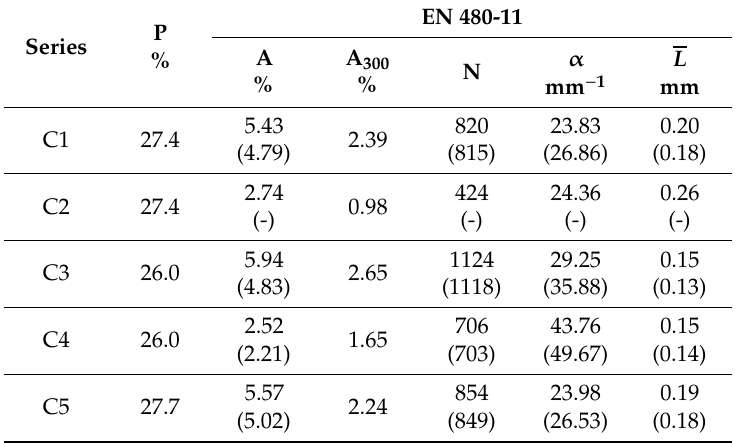
Table 2. Results of the air void parameter assessment as per EN